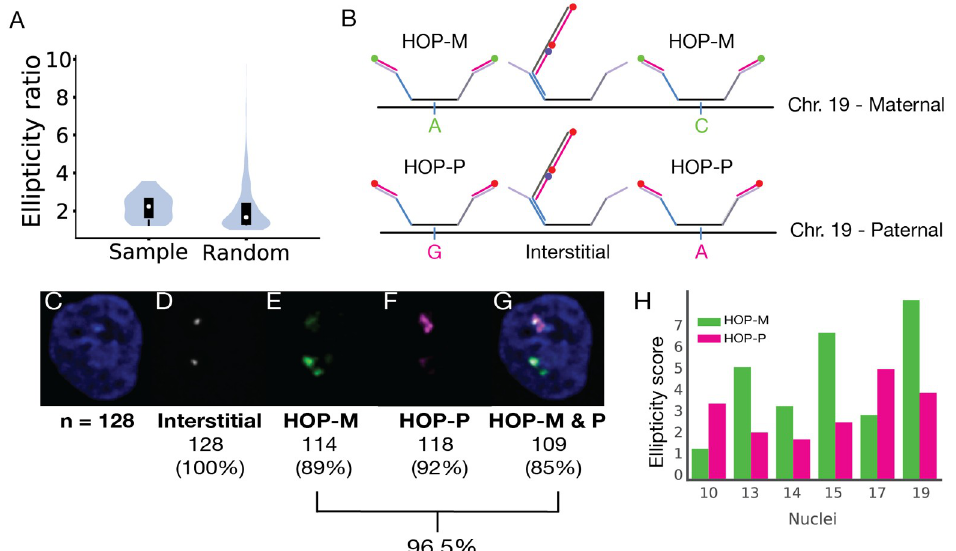
Fig 5. Homolog-specific Oligopaints for PGP1f. ( A ) Violin plots of the ratios of 19 pairs of ellipticity scores, each pair representing the two homologs of one of the 19 imaged nuclei (Sample) or of 1,000 pairs of ellipticity scores, each pair representing two chromosomes chosen at random from the 38 representing the 19 imaged nuclei (Random). Boundaries of the black box-plot represent 1st and 3rd quartiles, white dot represents the median, and whiskers extend to 1.5 times the interquartile range (Mann-Whitney rank test, � : p < 10 − 2 ). ( B ) The HOP-M and HOP-P probes for chromosome 19 each encompass the entire chromosome and contain 11,259 oligos that cover � 1 SNV per oligo. Thus, they are in contrast to Oligopaint oligos used to image CS1-9, these latter probes being “interstitial” in nature, as they avoid SNVs. HOP-M and HOP-P probes are visualized with secondary oligos labeled with different dyes, such that the two probes can be distinguished. ( C-G ) Images of a nucleus visualized with DAPI ( C , blue), an interstitial probe targeting just CS3 ( D , grey), HOP-M ( E , green, Atto488N), HOP-P ( F , magenta, Atto565N), and all probes ( G ), the latter demonstrating co-localization of all signals (n = 128); percentages show efficiency of each probe configuration, with a combined efficiency of 96.5%. ( H ) Ellipticity for the maternal (green) and paternal (magenta) homologs of the 6 nuclei for which HOPs had been